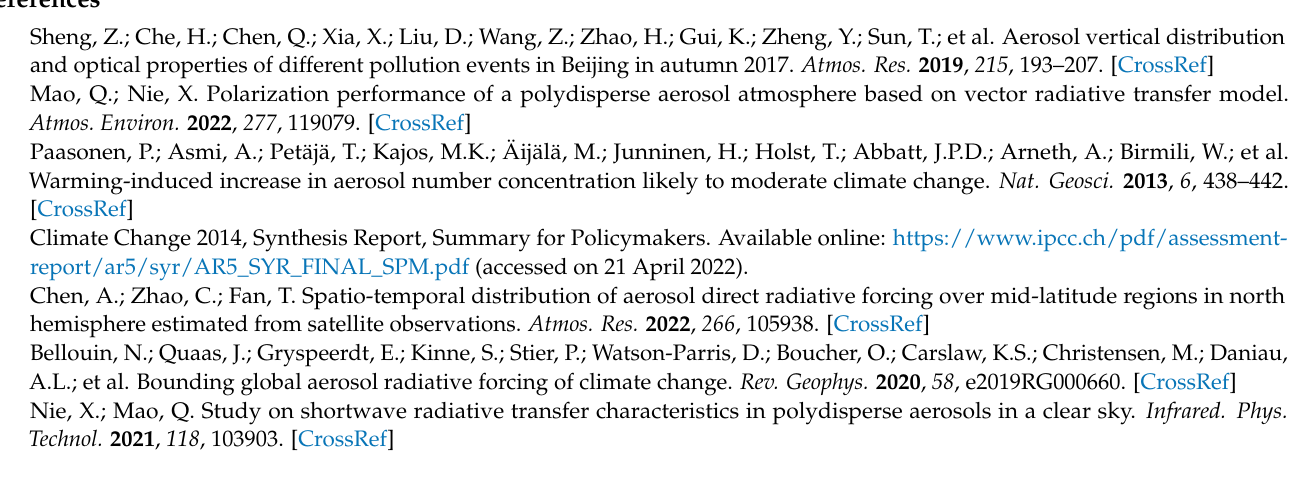
Figure A4. The extinction factor as a function of wavelength and particle size.